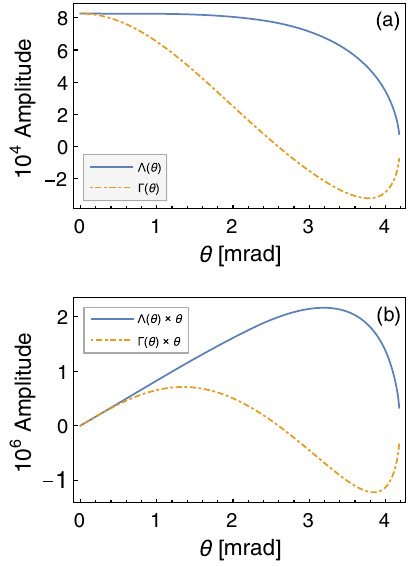
FIG. 2. Laser-induced energy (a) and angular (b) modulation amplitudes as functions of the laser incident angle. Λ ð θ Þ and Λ ð θ Þ × θ refer to the energy and angular modulation amplitudes of laser incident in the z − y plane, respectively. Γ ð θ Þ and Γ ð θ Þ × θ refer to the energy and angular modulation amplitudes of laser incident in the z − x plane.